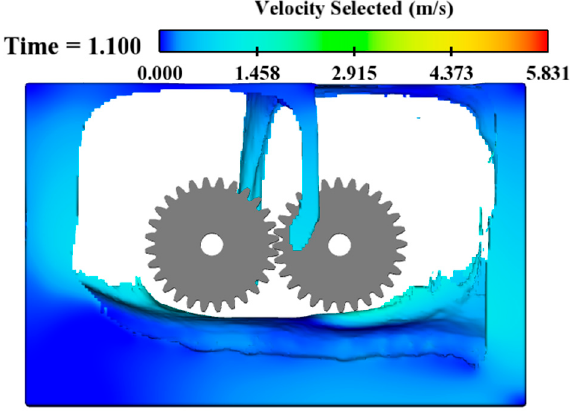
Figure 11. Oil flow field and velocity distribution inside the gearbox ( n = 1000 rpm).